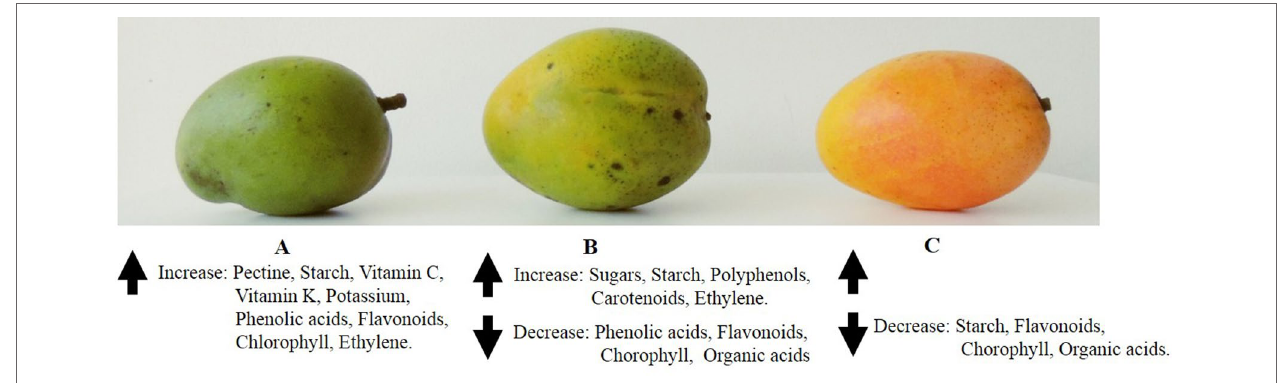
FIGURE 2 | Pictorial representation of ripening stages of “Criollo” mango fruit where changes of most representative phytochemicals are